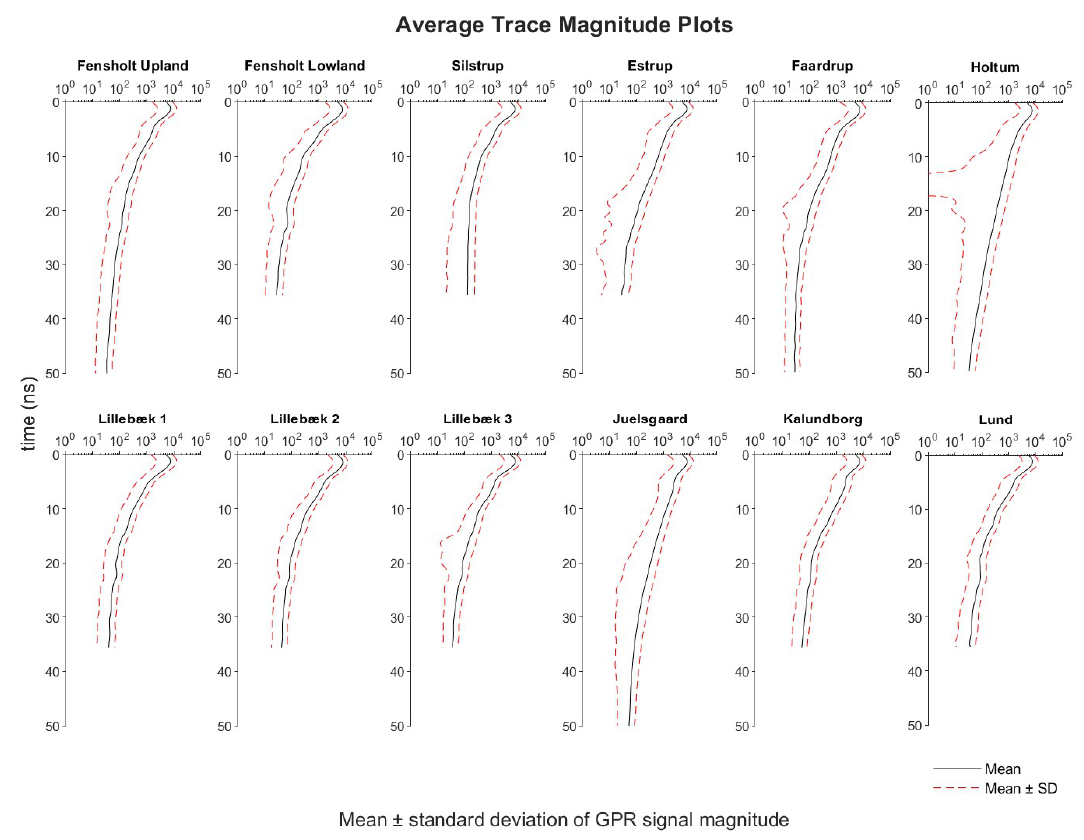
Figure 8. Average trace magnitude (ATM) plots for all the study